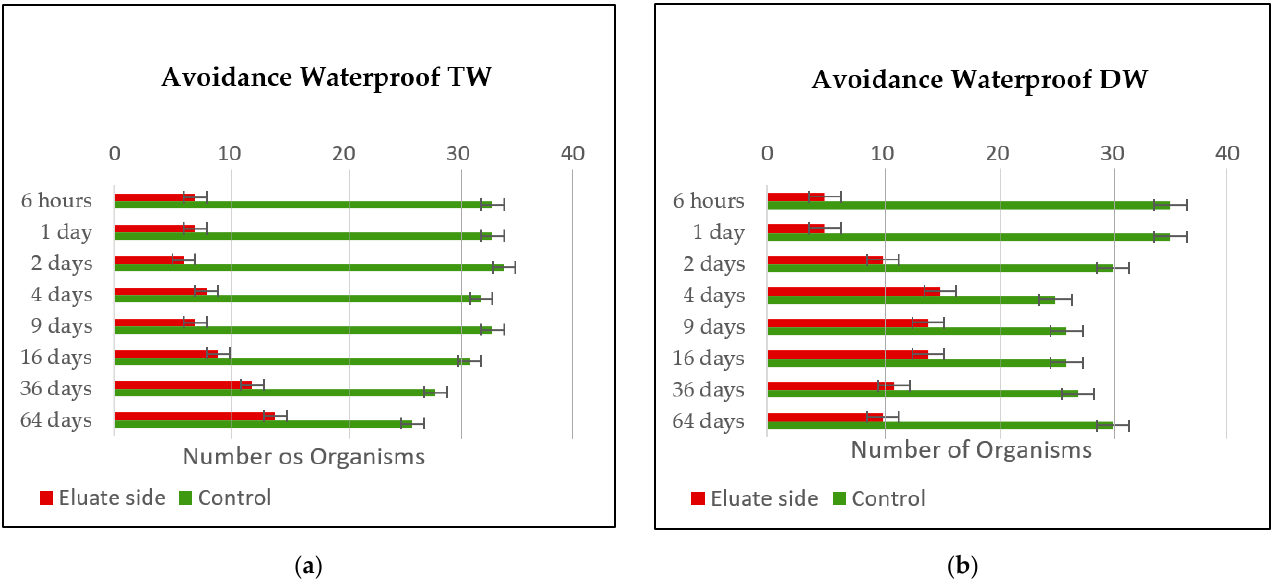
Figure 7. ( a ) Enchytraeid avoidance results for the waterproof leach using tap water. ( b ) Enchytraeid avoidance results for the waterproof leach using distilled water.